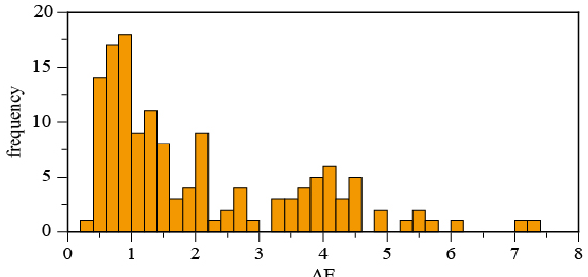
Figure 2. Color reproduction Δ E analysis result.